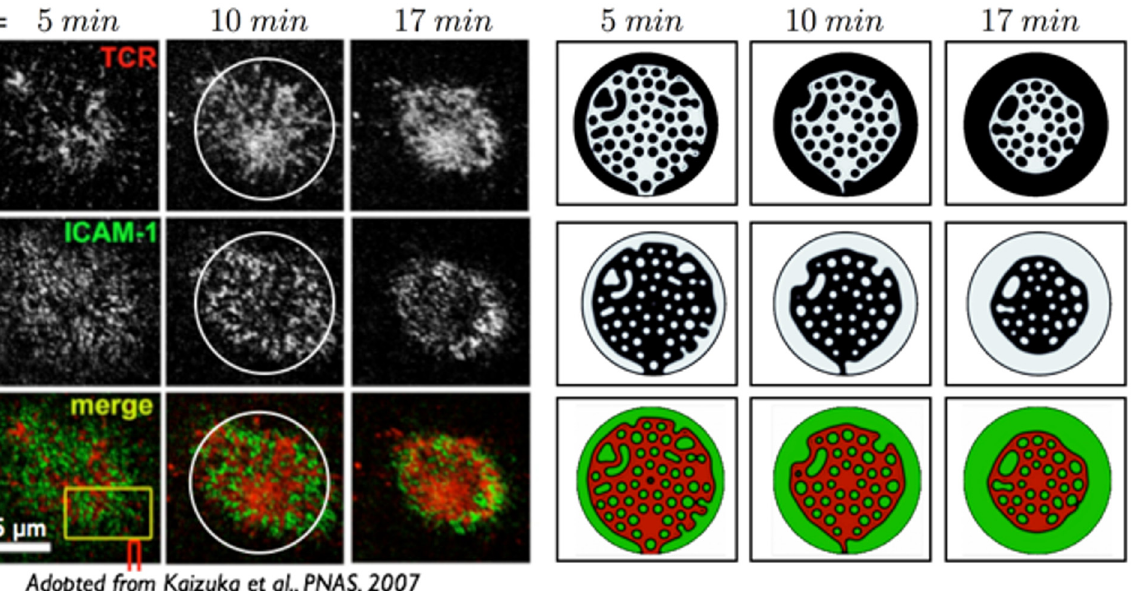
Fig 2. Comparison between an experimental (left) and numerical (right) realization of the TCR-pMHC and LFA-ICAM protein patterning dynamics in the IS. The simulations are based on Eqs 1 – 4 allowing fluid flux at the edge of the IS, where the height and number of proteins per membrane area is fixed. In the experiment a T-cell interacts with an antigen seeded lipid bilayer [20]. The upper row shows the density of bonded TCR-pMHC, the middle row the bonded LFA-ICAM proteins and the last row their union. The right panel shows the numerical simulation with B = 2 × 10 − 9 and τ = 15 with non-dimensional Þ 2 (cid:9) t ¼ ½ 1 : 7 ; 3 : 3 ; 5 : 7 (cid:10) . All other non-dimensional numbers are reported in Table 2. At short-times, protein clusters nucleate on the membrane, with a times ð h 0 L dynamics given by the interplay between membrane mechanics, protein kinetics and fl uid fl ow. At late times protein clusters interact and coalesce into large spatial patterns that mimic pSMAC and cSMAC structures. A “ donut shaped ” LFA ring surrounds a dense TCR region at the center of the synapse at late times.